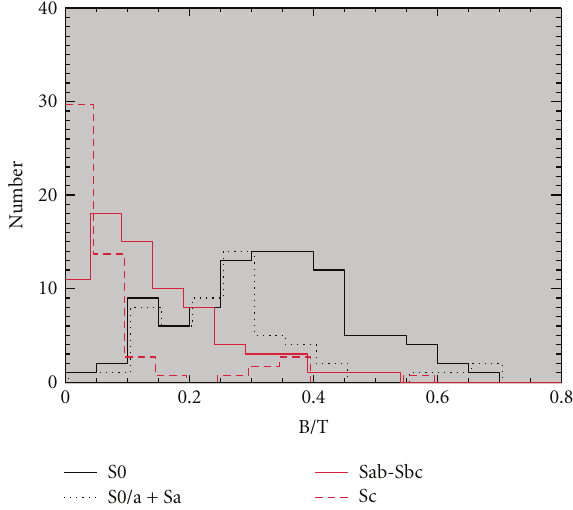
Figure 8: Histogram of the B/T flux ratios in K s -band, corrected for galactic and internal dust extinction. The corrections are di ff erent for the bulge and the disk. The histograms for the S0s (full line), and the S0/a galaxies (dotted line) are based on the NIRS0S sample. For spirals the lines for Sab-Sbc (full red line) and later than Sc (dashed red line) are drawn using the OSUBSGS sample. This figure was originally published by Laurikainen et al.